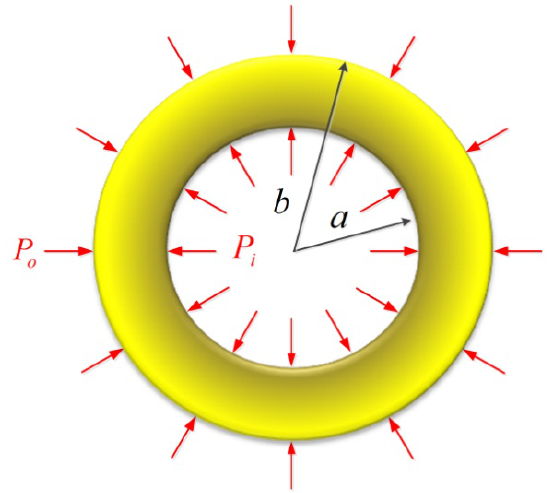
Figure 1. Configuration of an FGM disk with radially varying